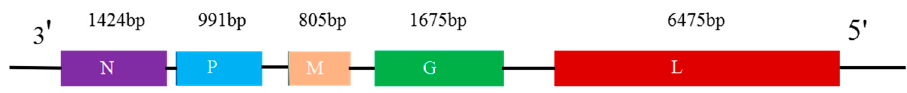
Figure 1. Genome structure of rabies virus.